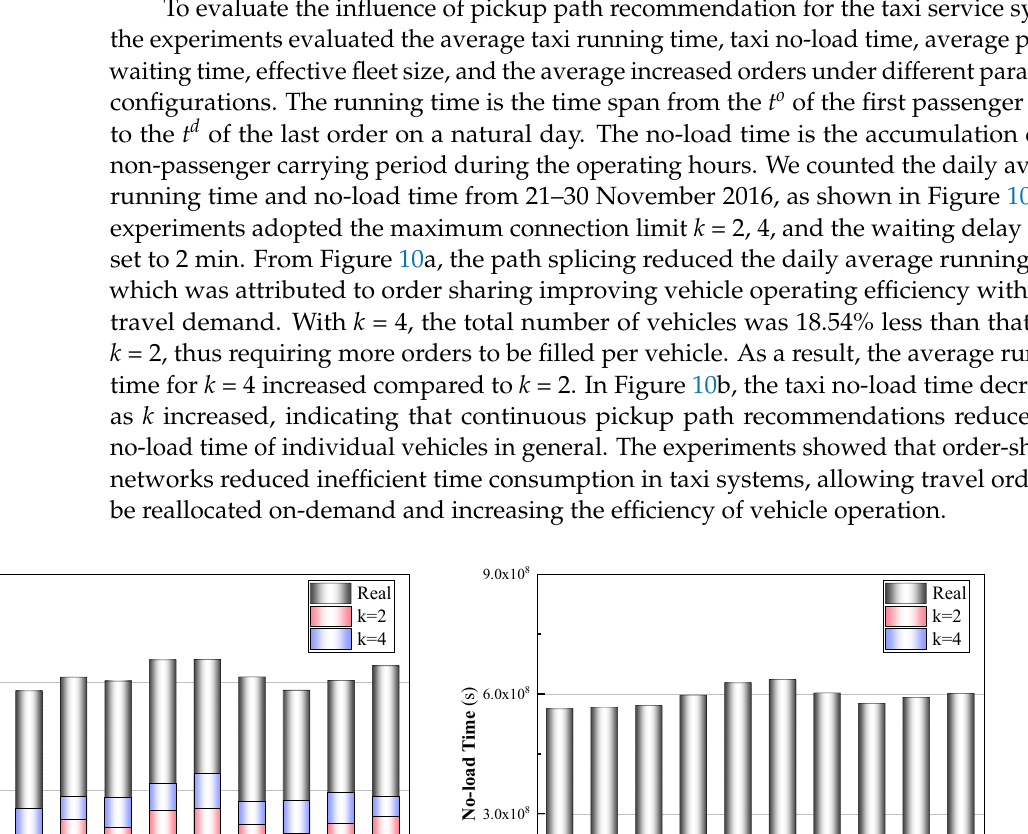
Table 2. The average pickup waiting time (/s) in CTPURec with different k.